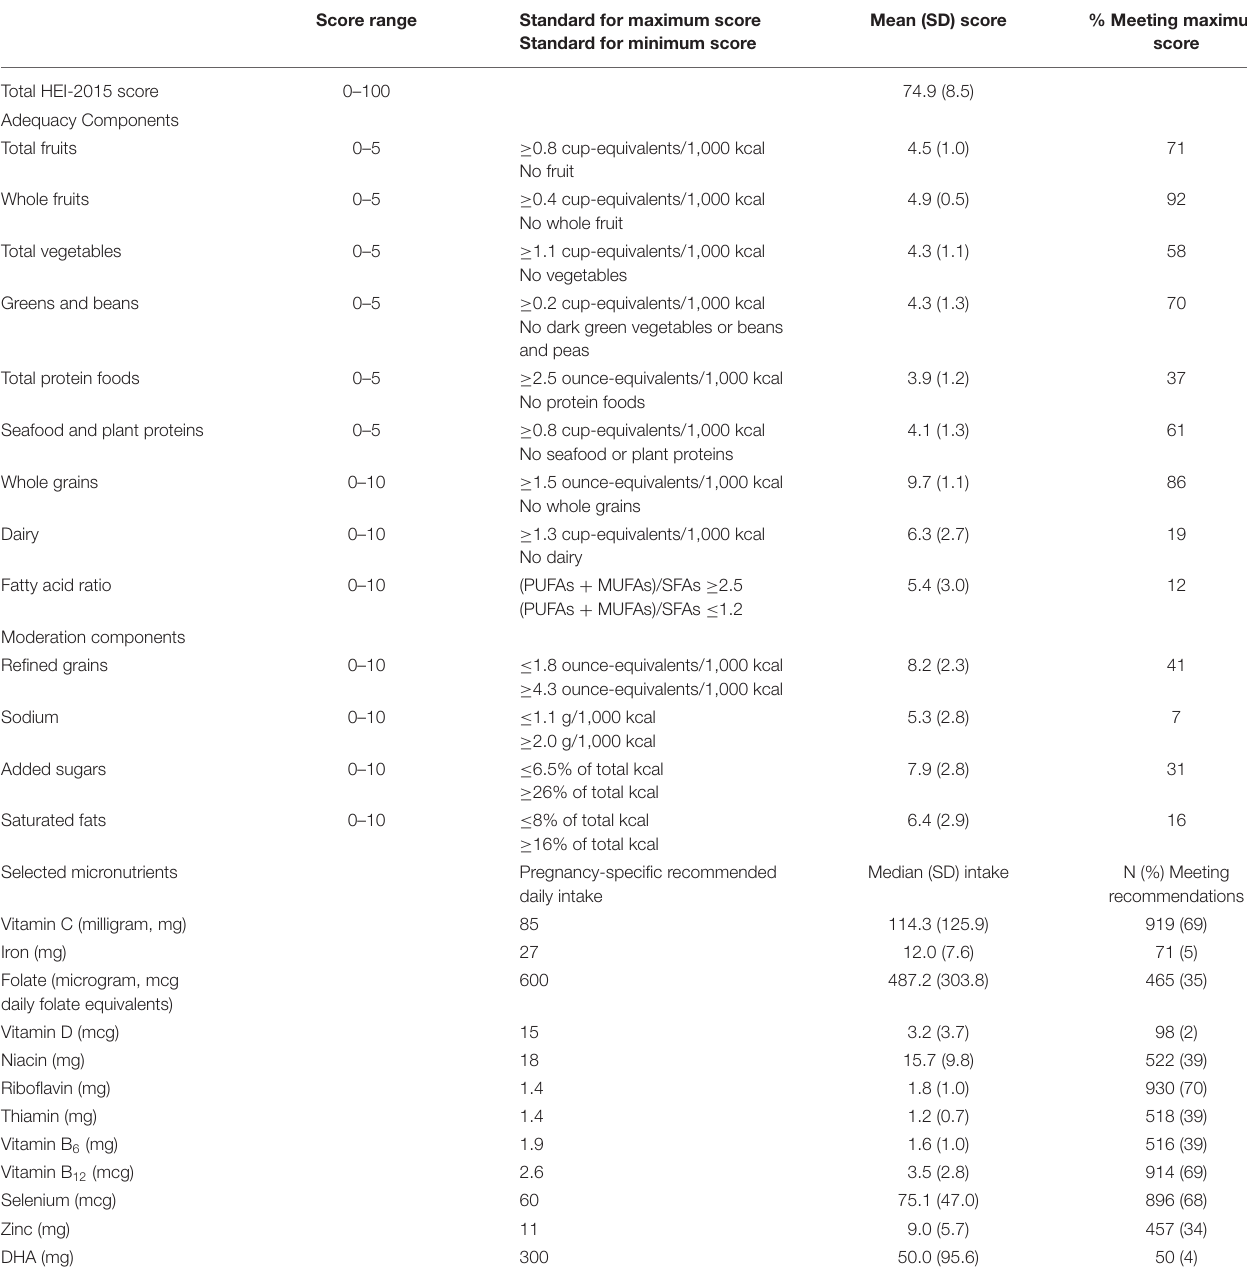
TABLE 1 | Description of Healthy Eating Index-2015 (HEI-2015) scores and selected nutrient intakes among pregnant women participating in the New York University Children’s Health and Environment Study ( n =